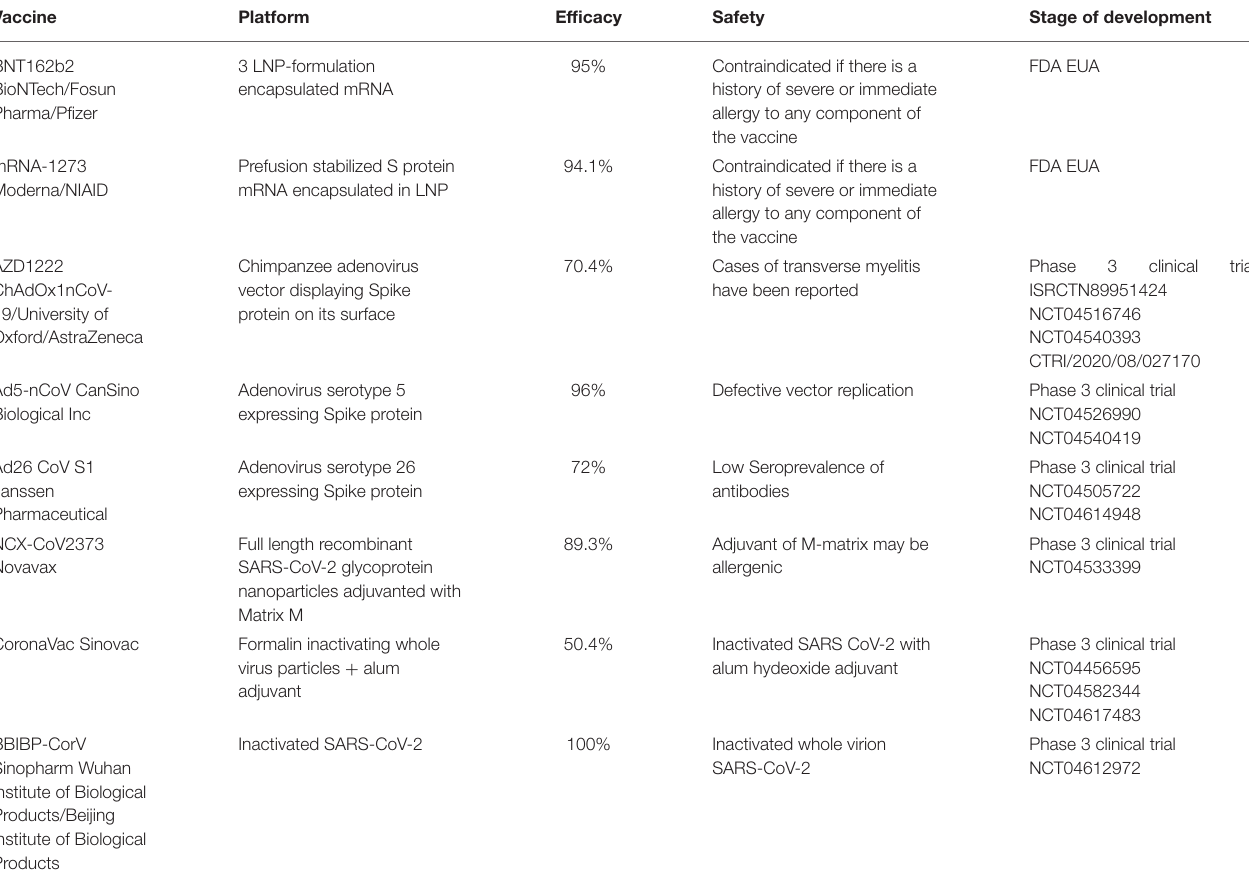
TABLE 5 | The efficacy and current status of COVID vaccines.